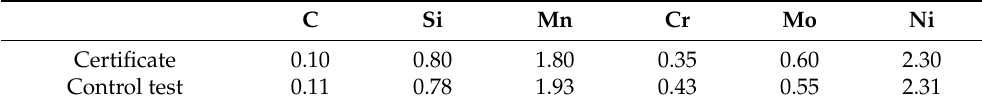
Table 2. Chemical composition of the Union X96 welding